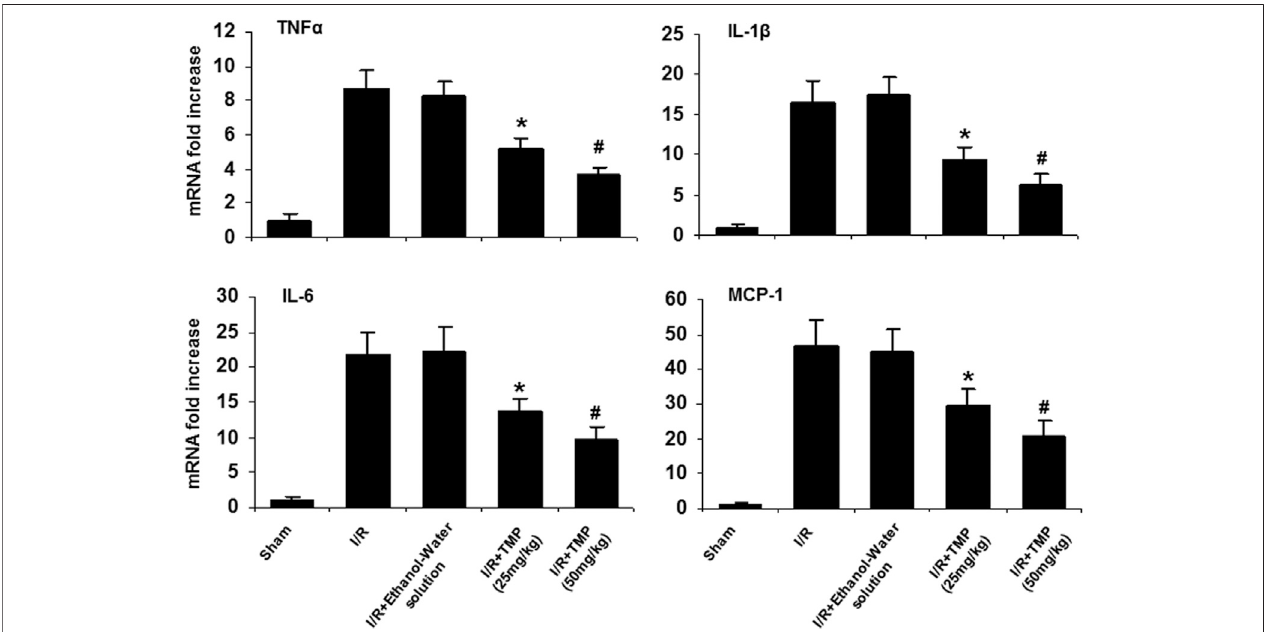
FIGURE3| TMPreducesexpression ofpro-in fl ammatory cytokines inthe ischemic murine brain. TheC57/BL mice were treated withTMP 25 mg/kg or 50 mg/kg or vehicle administered intraperitoneally12 h beforeand after 2 h ofMCAO,followed by24 hreperfusion. mRNAlevels ofTNF α ,IL-1 β , IL-6,and MCP-1 were measured by qRT-PCR and expressed as fold changes of sham-operated controls. Elevated mRNA levels of TNF α , IL-1 β , IL-6, and MCP-1 were observed in the mice brains subjected to cerebral ischemia/reperfusion injury compared to the sham-operated mice. The elevated mRNA levels of these cytokines in the ischemic brain were signi fi cantly reduced by treatment with TMP in a dose-dependent manner. * p < 0.05, # p < 0.01, n (cid:1) 6 per